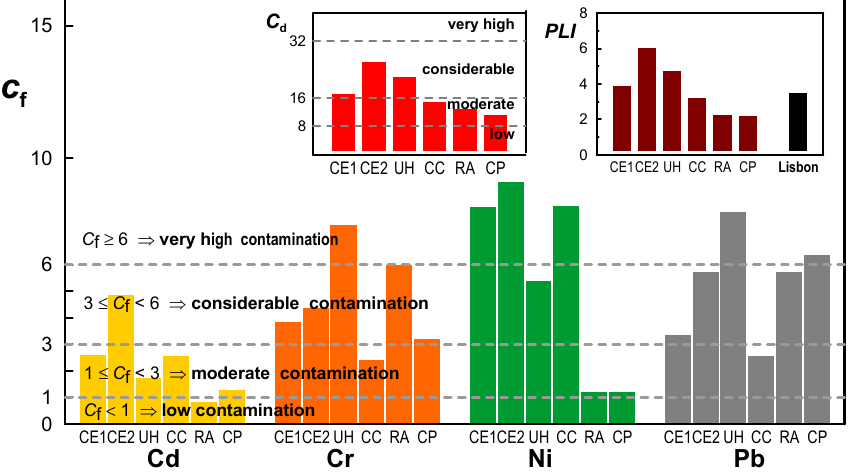
city entrances (CE2) showing a “moderate contamination” level.